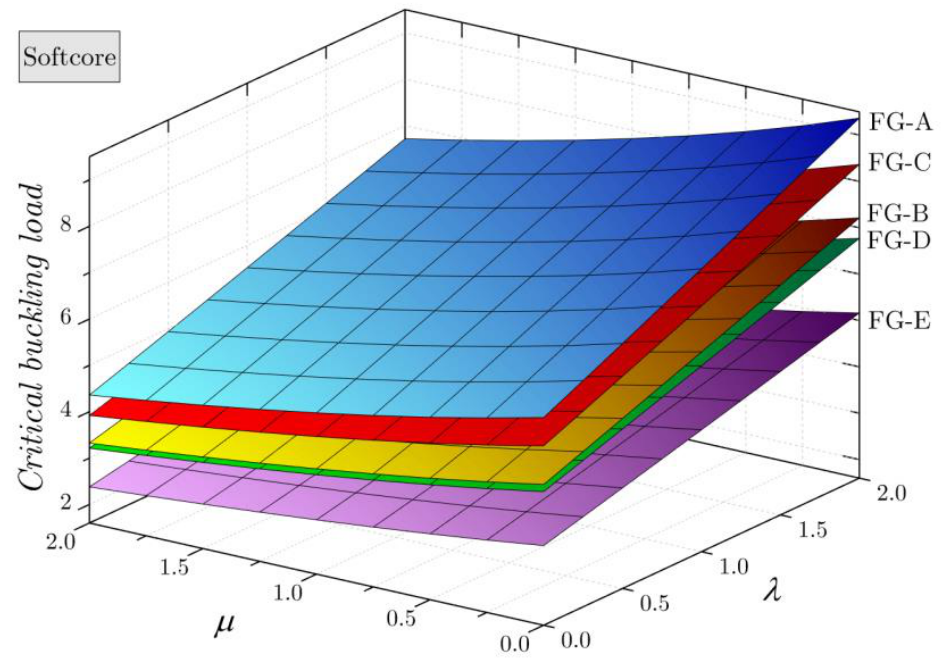
Figure 10. Effect of the nonlocal and length-scale parameters on the dimensionless critical buckling load 𝑁̅ of FG nanoshells (𝑆𝑆𝑆𝑆, 𝑅 = 5, 𝑝 = 𝑘 = 𝑒 = 2, 𝑏 = 𝑎 = 10ℎ, 𝐺